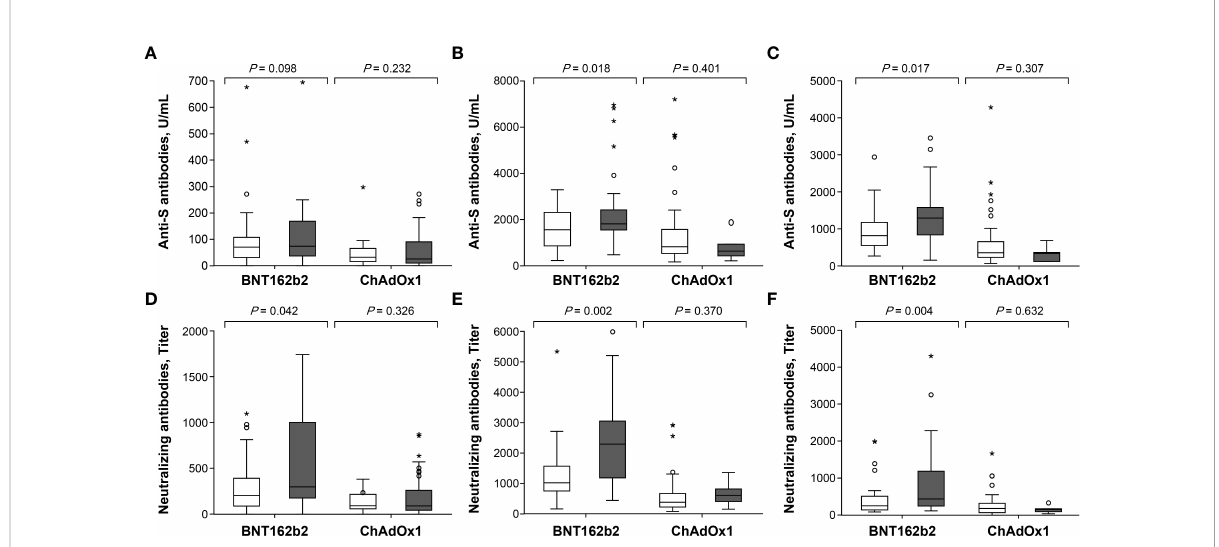
FIGURE 5 Comparison of antibody response after the fi rst and second dose in ChAdOx1 nCoV-19 and BNT162b2 recipients with respect to febrile adverse events: (A) anti-S antibodies at 3 weeks after the fi rst dose, (B) anti-S antibodies at 3 weeks after the second dose, (C) anti-S antibodies at 12 weeks after the second dose, (D) neutralizing antibodies at 3 weeks after the fi rst dose, (E) neutralizing antibodies at 3 weeks after the second dose and (F) neutralizing antibodies at 12 weeks after the second dose. □ Vaccine recipients without febrile adverse events. ▪ Vaccine recipients with febrile adverse events. Symbol * within graph is data value along with